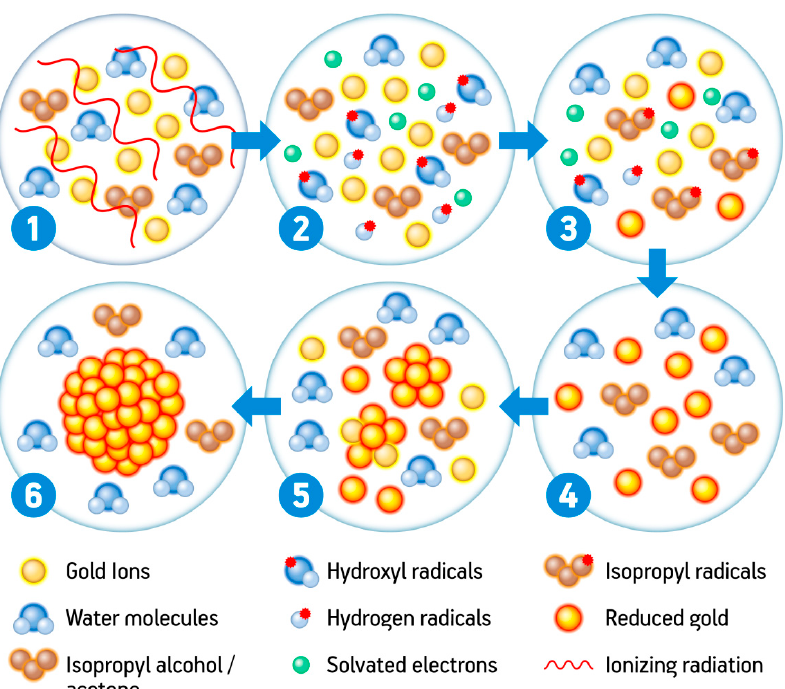
Figure 2. Representative scheme of the synthesis of gold nanoparticles using high energy radiation.